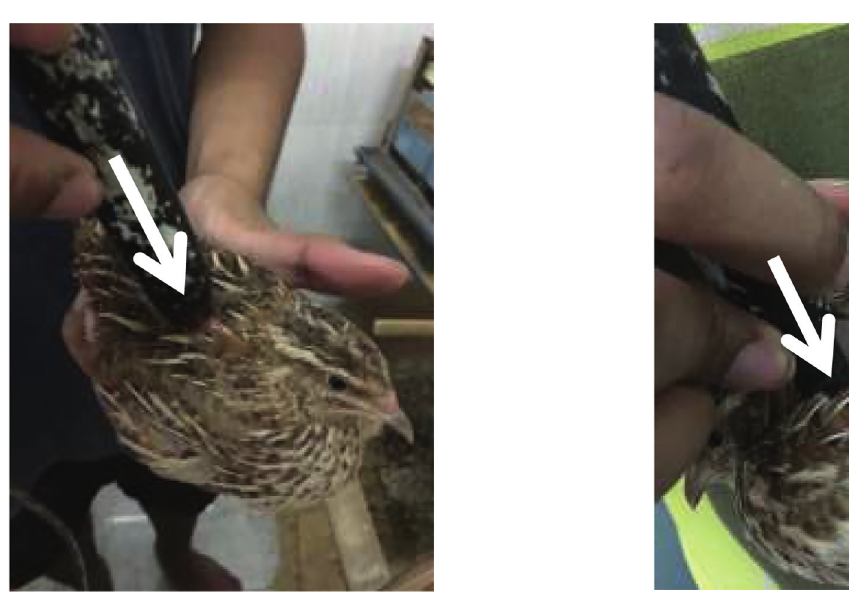
Figure 1: Laser puncture shooting at the Ova point.